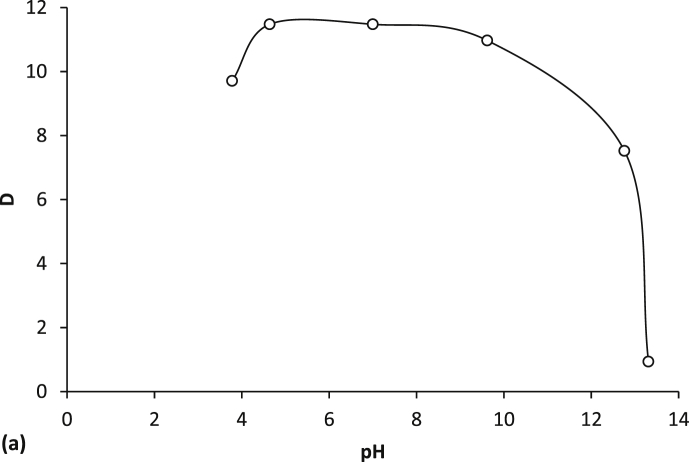
Dependence of distribution coefficients for aromatic acids on the рН value of the medium in the PEG-1500 (15 wt %) – Na2SO4 (9 wt %) – H2O ATPS: a – salicylic acid, b – sulfosalicylic acid, and c – benzoic acid.